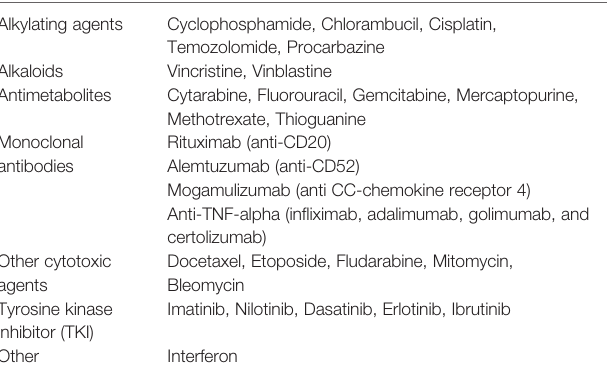
TABLE 2 | Cytotoxic or immunosuppressive agents associated with HBV reactivation (6, 11). Alkylating agents